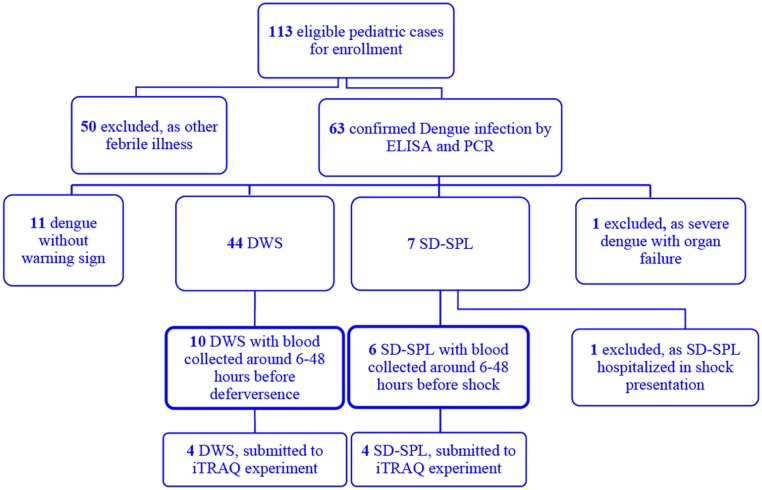
Study profile.Of 113 patients enrolled, 63 had laboratory-confirmed dengue infection. One patient hospitalized in shock presentation was excluded. Six SD-SPL and ten DWS, with early stage plasma collected, were included in the current study.